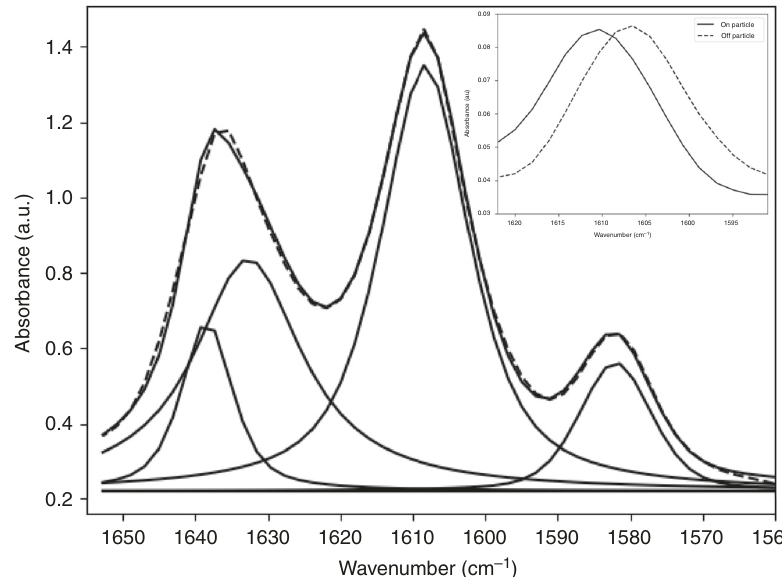
Fig. 4 Residual aromatic strain analysis. Deconvolution of the aromatic (1581 and 1608 cm − 1 ) and aliphatic ( cis = 1632.5 cm − 1 , trans = 1638.5 cm − 1 ) peaks to indirectly quantify residual strain. (Inset) The principal aromatic peak (1608cm − 1 ) shifts from a higher to a lower wavenumber value corresponding to ‘ on ’ and ‘ off ’ particle positions,